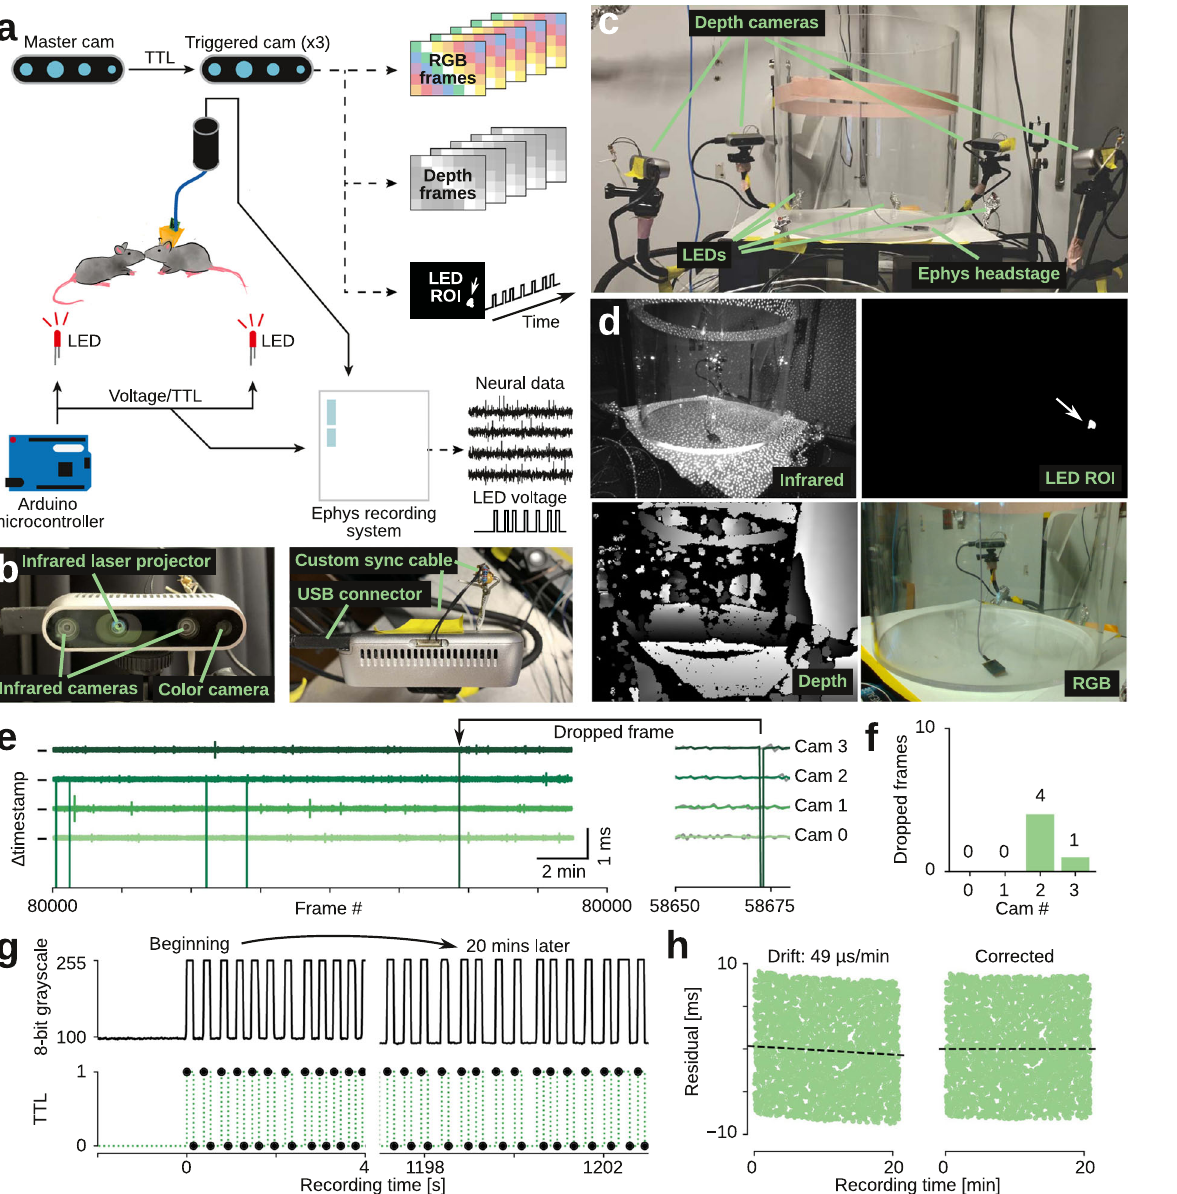
Fig. 1 Raw data acquisition, temporal alignment, and recording stability. a Schematic of recording setup, showing the fl ow of synchronization pulses and raw data. We use a custom Python program to record RGB images, depth images, and state (on/off) of synchronization LEDs from all four cameras. Neural data and TTL state of LEDs are recorded with a standard electrophysiology recording system. We use a custom Python program to record video frames over USB (60 frames/s) and automatically deliver LED synchronization pulses with randomized delays via Arduino microcontroller. b Close-up images of the depth cameras, showing the two infrared sensors, color sensor, and cables for data transfer and synchronization. c Photograph of recording setup, showing the four depth cameras, synchronization LEDs, and circular behavioral arena (transparent acrylic, 12 ” diameter). d Example raw data images (top left: single infrared image with visible infrared laser dots; top right: corresponding automatically-generated mask image for recording LED synchronization state (arrow, LED location); bottom left: corresponding depth image, estimated from binocular disparity between two infrared images; bottom right: corresponding color image). e Inter-frame-interval from four cameras (21 min of recording). Vertical ticks indicate 16.66 ms (corresponding to 60 frames/ s), individual cameras are colored and vertically offset. Frame rate is very stable (jitter across all cameras: ±26 µ s). Arrow, example dropped frame. f Number of dropped frames across the example 21 min recording. g Top row, LED state (on/off) as captured by one camera (the 8-bit value of central pixel of LED ROI mask), at start of recording and after 20 min of recording. Bottom row, aligned LED trace, as recorded by electrophysiology recording system. h Temporal residuals between recorded camera LED trace ( g , top) and recorded TTL LED trace ( g , bottom) are stable, but drift slightly (49 μ s/min, left panel). We can automatically detect and correct for this small drift (right panel). Source data are provided as a Source Data fi le.